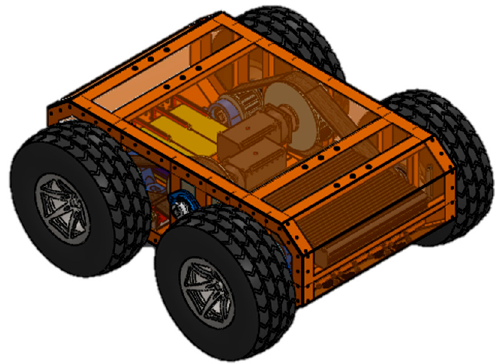
Figure 5. Configuration of the Mobile Robotic Platform.